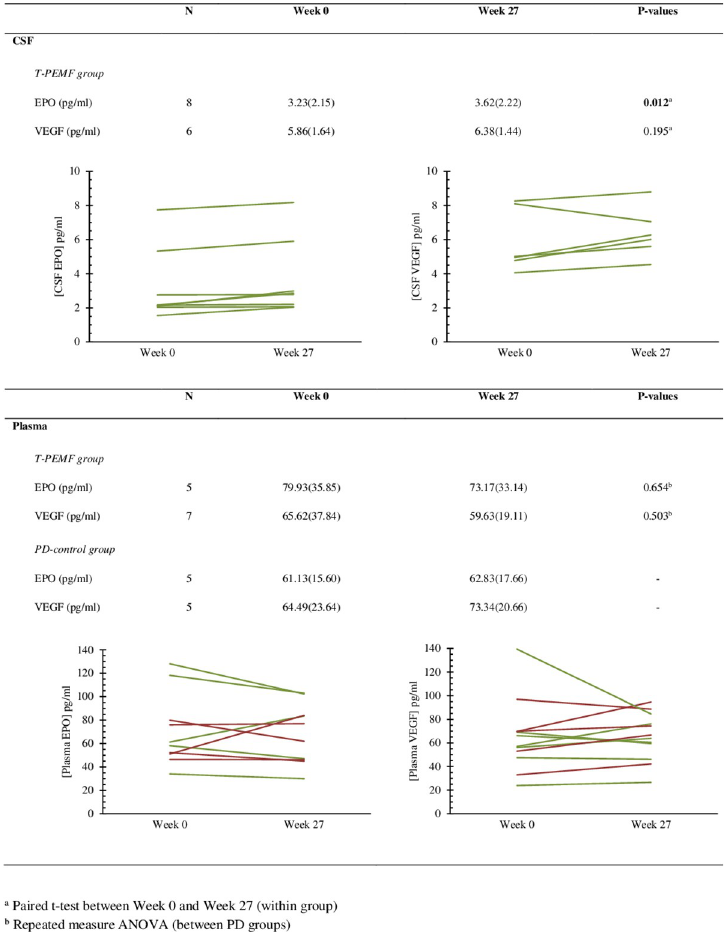
Fig 4. Erythropoietin (EPO) and vascular endothelial growth factor (VEGF). Group mean (SD) of erythropoietin and vascular endothelial growth factor concentration in cerebrospinal fluid (CSF) and plasma in patients with Parkinson’s disease who were either treated with transcranial pulsed electromagnetic field treatment (T-PEMF, green lines) or were in the PD-control group (red lines). Individual values are displayed.